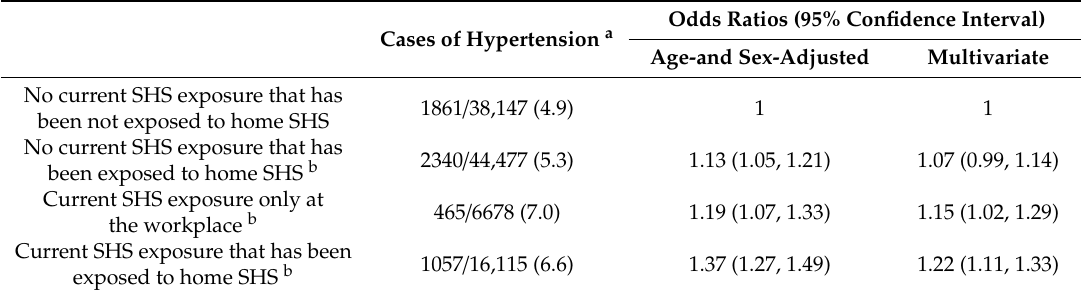
Table 3. Multivariate logistic regression analyses for the association of hypertension with type of secondhand smoke exposure in